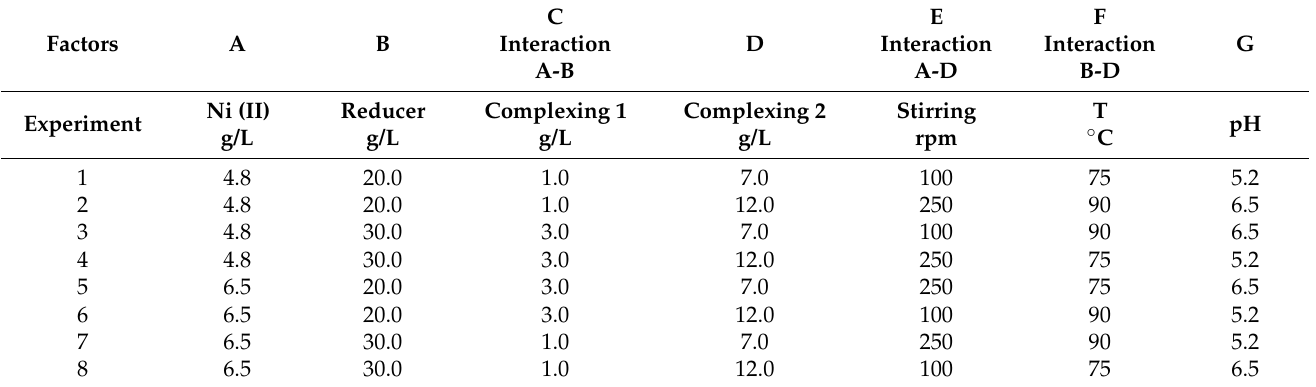
Table 1. Experimental matrix derived from L 8 orthogonal array